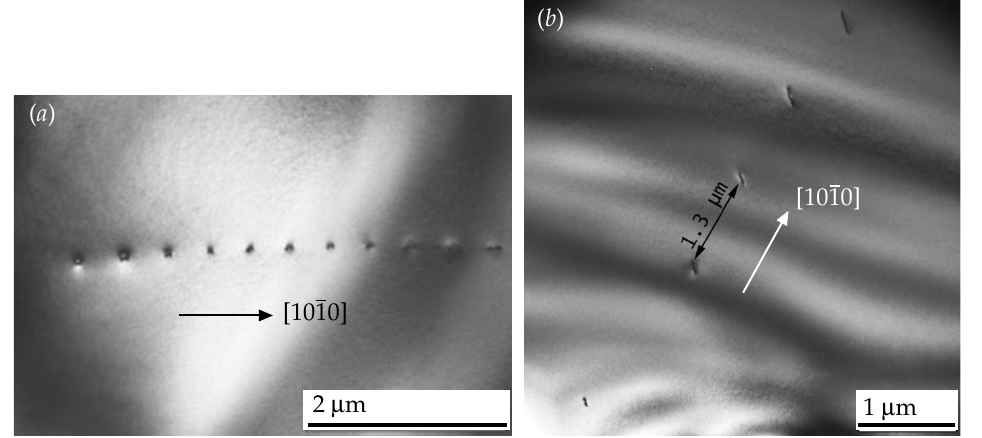
(cid:10) (cid:11) Figure 7. ( a ) an 1010 array of threading dislocations; ( b ) dislocation lines significantly tilted from the [ 0001 ]